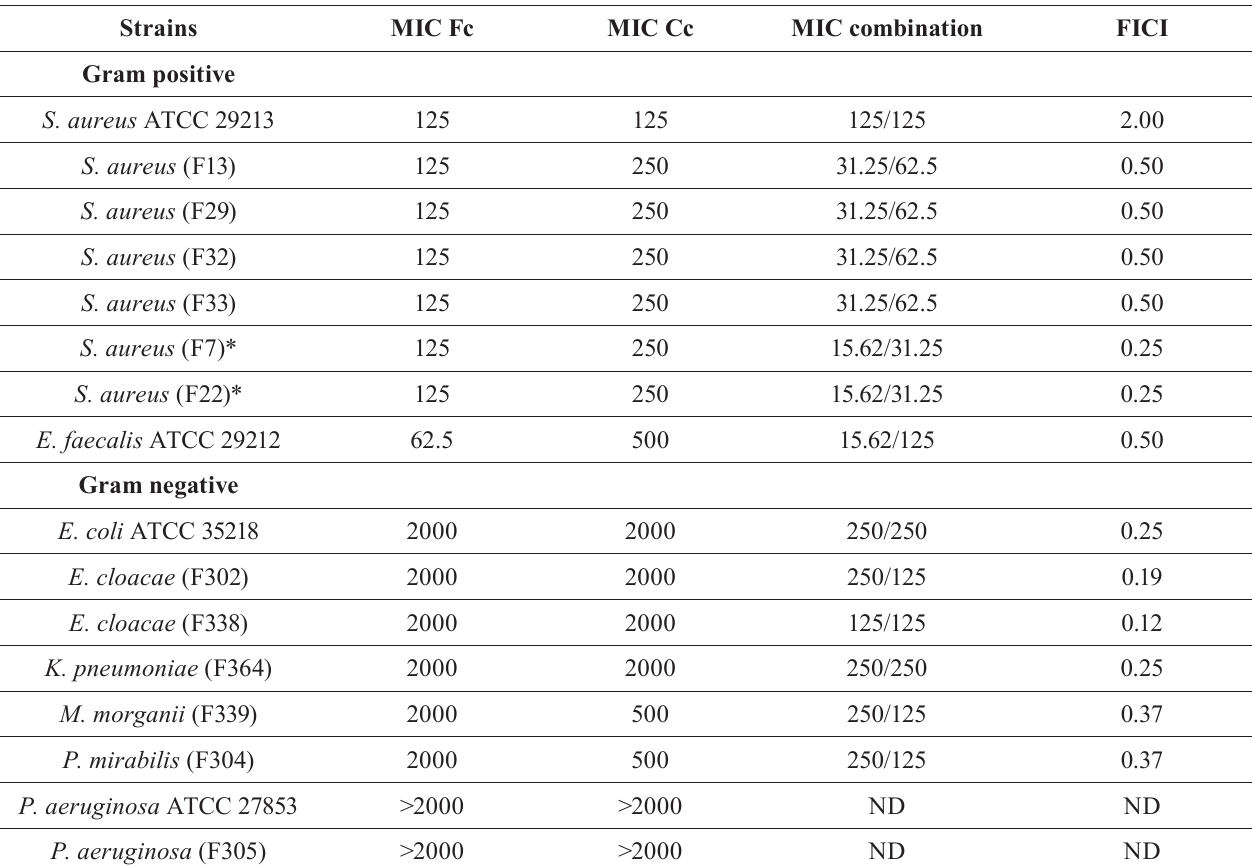
TABLE I - E ffect of the combinations of F. caudigera and C. convoluta extracts on pathogenic bacteria